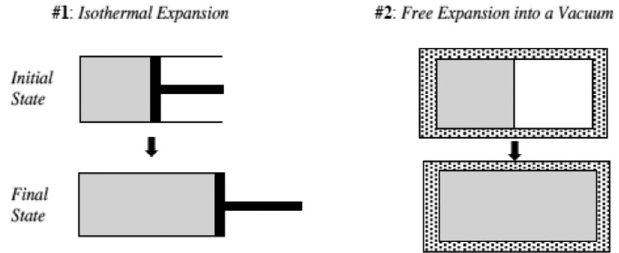
FIG. 4. Diagram provided to students in the prompt of the expansions question. This figure was taken from Bucy